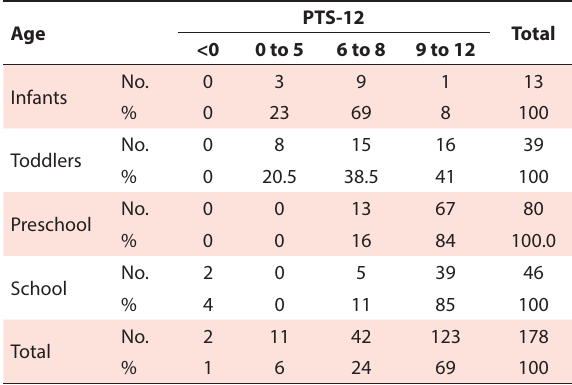
Table 2. Distribution of age groups with